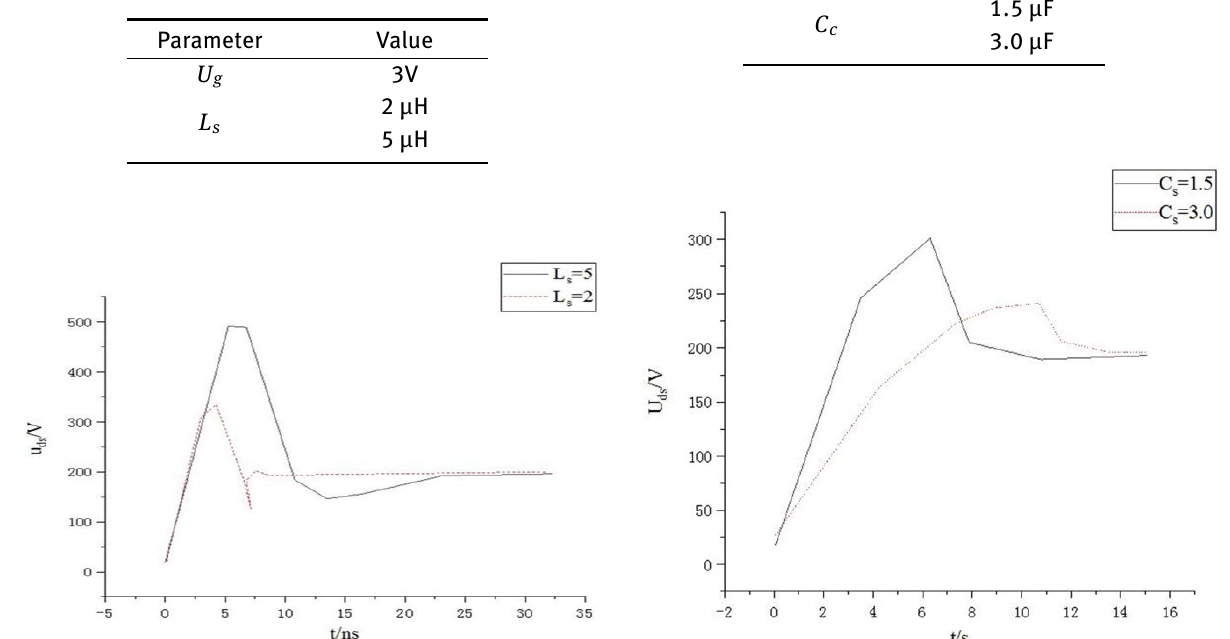
Figure 7: Simulation curve of source-drain voltage under different C